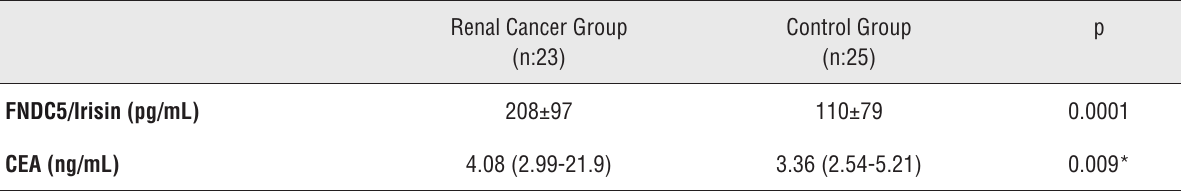
Table 1 - fNDc5/irisin and cEA levels.